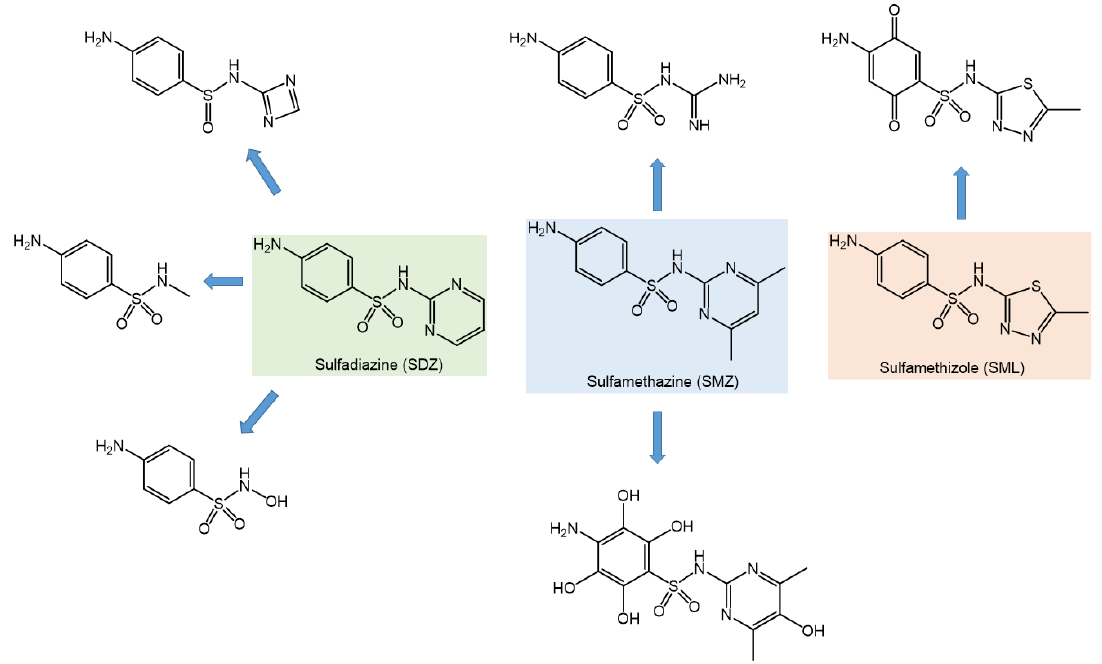
Figure 5. Sulfonamide degradation mechanism through Fe (0-VI)/sulfite systems.